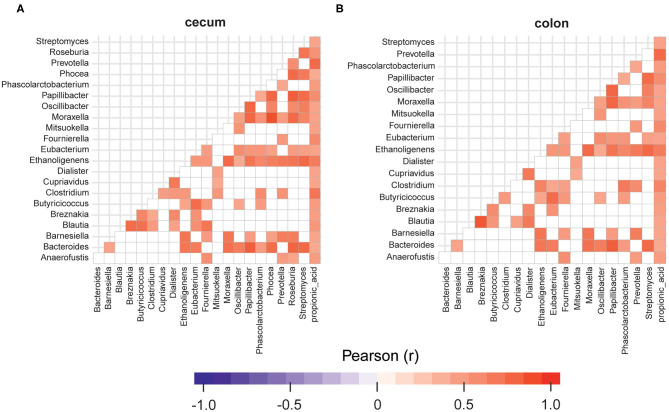
Relationships between the groups of differentially abundant microorganisms identified in cecum (A) and colon digesta (B) of the animals fed with the diet containing 40% yeast protein. The red color corresponds to a statistically significant positive correlation (p ≥ 95%) and the blue color corresponds to a negative correlation. Insignificant values are colored in white. n = 12 per group.